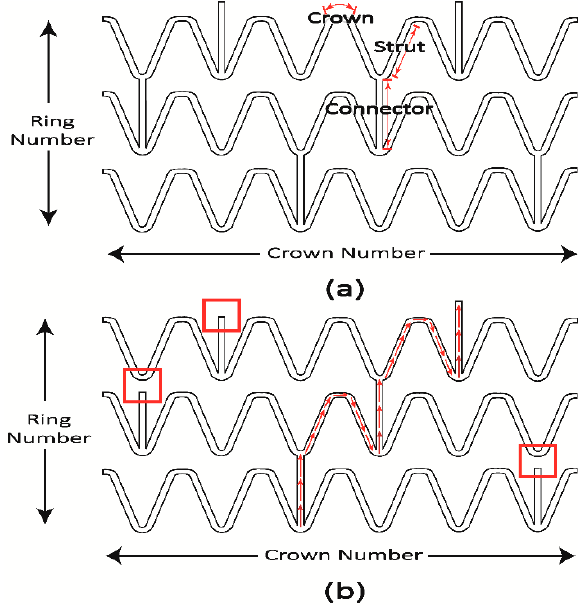
Figure 2. 2D planar geometries of ( a ) multi-connector, and ( b ) single-connector stent antennas. The red boxes indicate that a connector is disconnected between two adjacent rings. The red arrows indicate the surface current flow path at the resonant frequency.